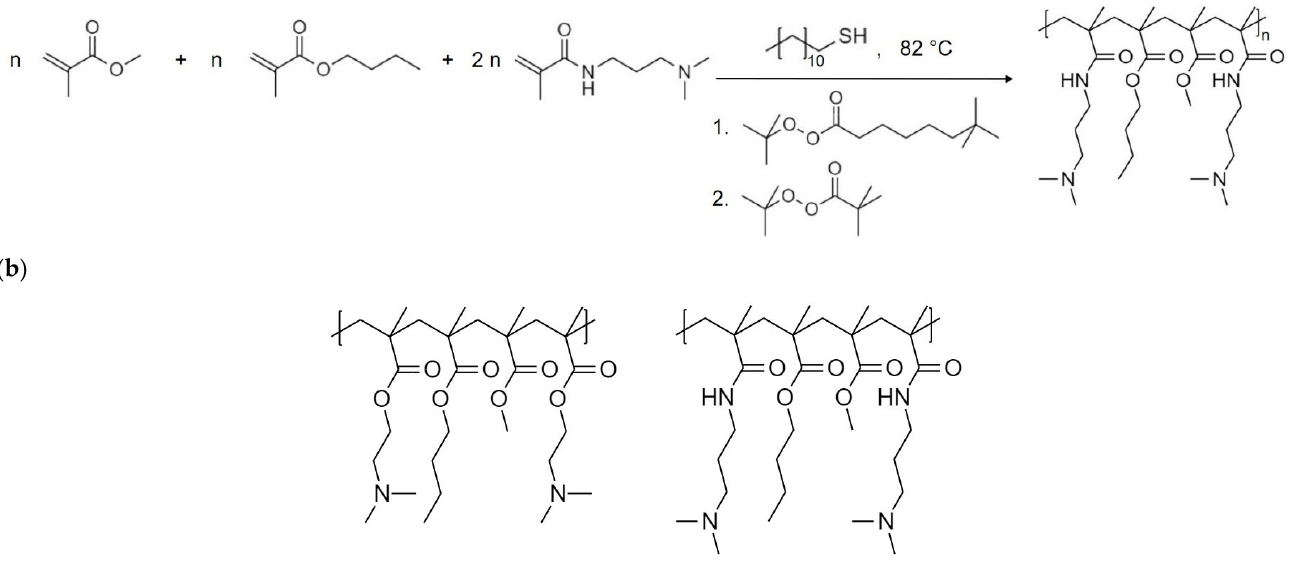
Figure 1. Radical copolymer synthesis of ModE including monomers, chain-transfer-agent (CTA), initiators (1. tert-butyl peroxyneodecanoate, and 2. tert-butyl peroxypivalate) and reaction conditions ( a ), and a section of the chemical structure of EUDRAGIT ® E PO (EPO) (left) and ModE (right) ( b ).